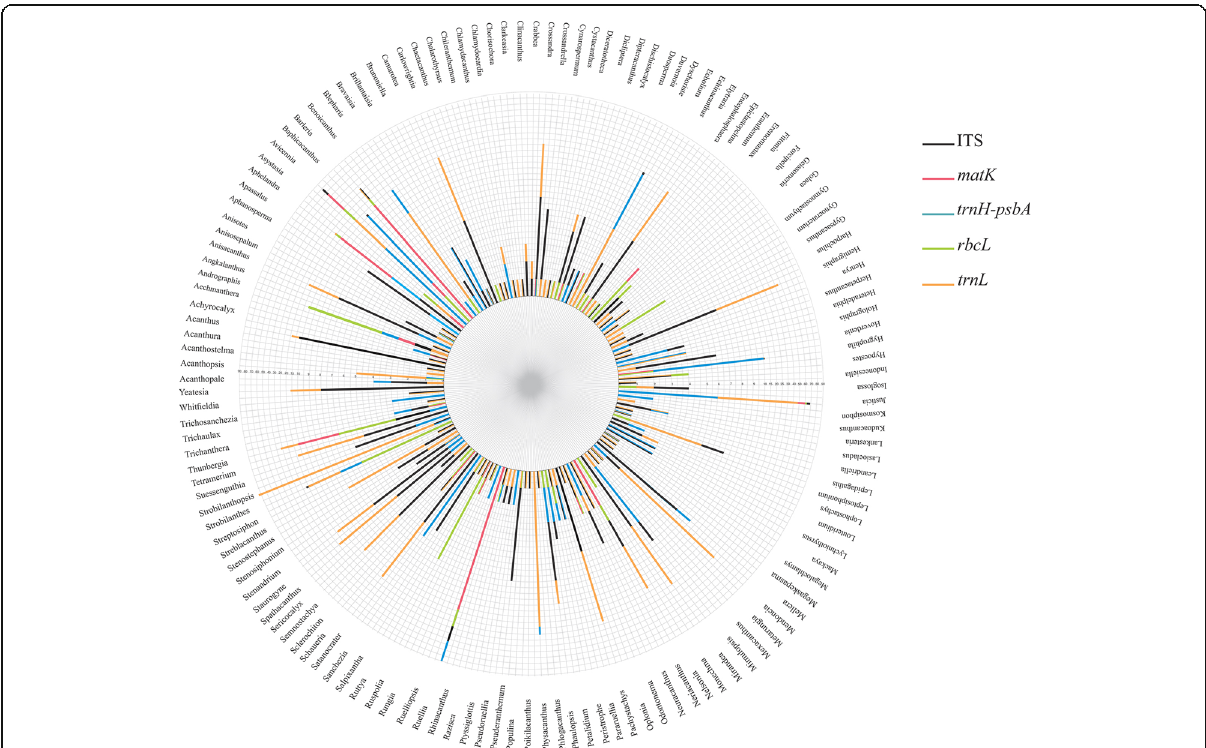
Fig. 2 DNA sequences of Acanthaceae plant species from five chloroplast regions ( matK , trnH-psbA spacer region , rbcL , trnL and ITS2) found in GenBank. In total of 2143 sequences from 140 genus were